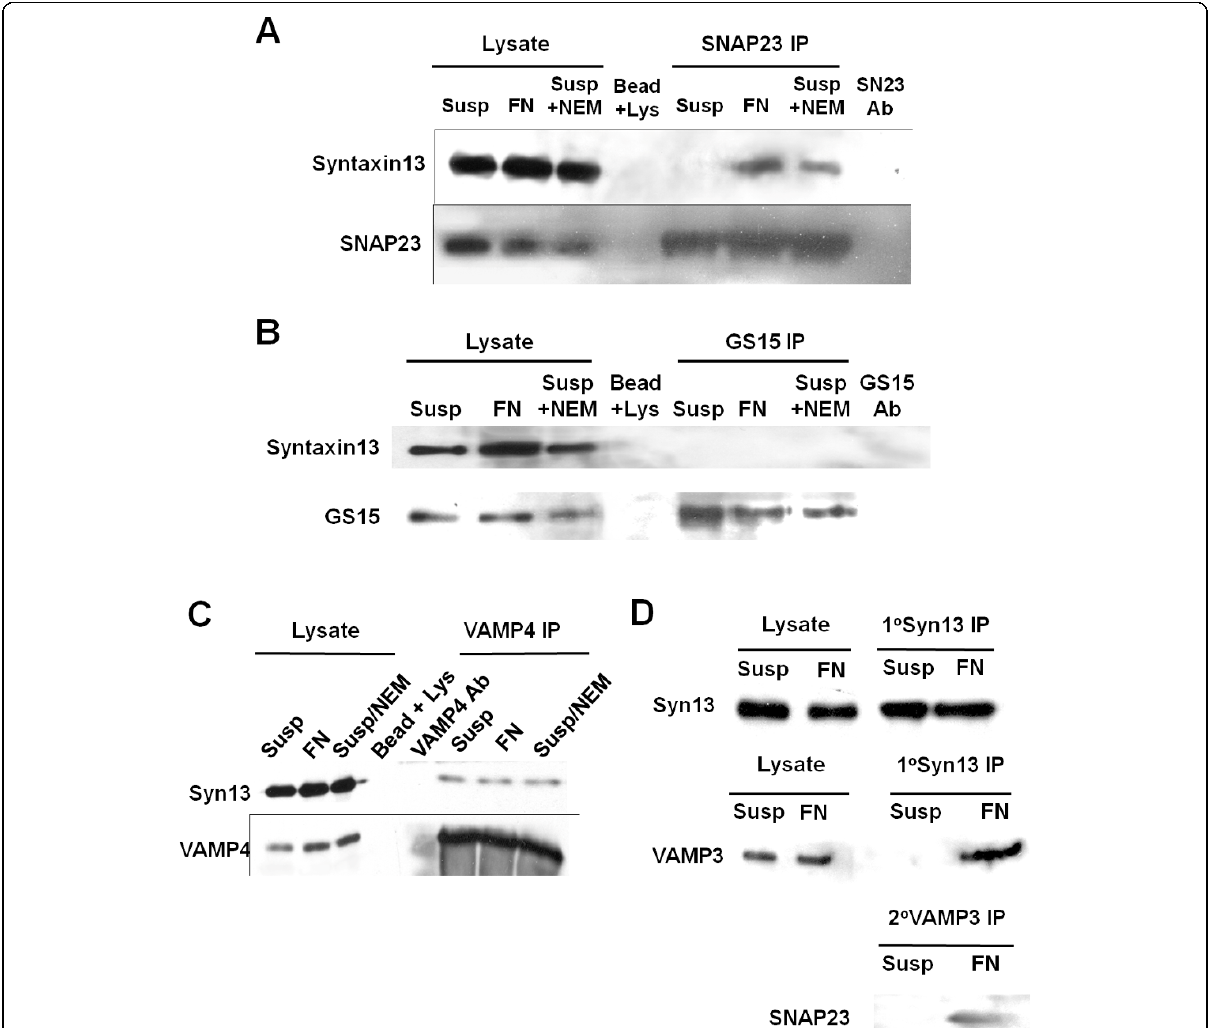
Figure 1 SNAP23-syntaxin13-VAMP3 interaction in CHO cells is stimulated by adhesion to FN . CHO-K1 cells were held in suspension after pretreatment with 1 mM NEM and 2 mM DTT ( Susp ), held in suspension after pretreatment with 1 mM NEM ( Susp + NEM ) or plated on FN ( FN ) for 20 min. The cells were lysed, and the indicated SNAREs were immunoprecipitated with antibodies coupled to sepharose beads from 1-1.5 mg of cellular protein. 10 μ g aliquots of the lysates from which SNAREs were immunoprecipitated were run in ‘ Lysate ’ lanes. ‘ S13 Ab ’ / ’ SN23 Ab ’ / ’ GS15 Ab ’ indicate syntaxin13, SNAP23 and GS15 antibody control immunoprecipitations, where antibodies coupled to sepharose beads were incubated with lysis buffer, washed, and analyzed. (A) Syntaxin 13 immunoblot of SNAP23 immunoprecipitates showing immunoprecipitation of syntaxin 13 from cells plated on FN and cells treated with NEM, upper blot , and the same membrane reprobed for SNAP23, lower blot . (B) Syntaxin 13 immunoblot of GS15 immunoprecipitates, upper blot, and the same membrane reprobed for GS15, lower blot . (C) Syntaxin13 immunoblot of VAMP4 immunoprecipitates, and the same membrane reprobed for VAMP4, lower blot . (D) CHO-K1 cells, held in suspension ( Susp ) or plated on FN ( FN ), were lysed and syntaxin13 was immunoprecipitated with anti-syntaxin13 antibody. The syntaxin13 immunoprecipitates were washed and an aliquot (10%) of the eluate was analyzed by SDS-PAGE-western blot for syntaxin13, upper blot , and co- precipitated VAMP3, middle blot . The remainder of the syntaxin13-immunoprecipitate was re-suspended and immunoprecipitated with anti- VAMP3 antibody and then analyzed by SDS-PAGE-western blot for SNAP23, lower blot